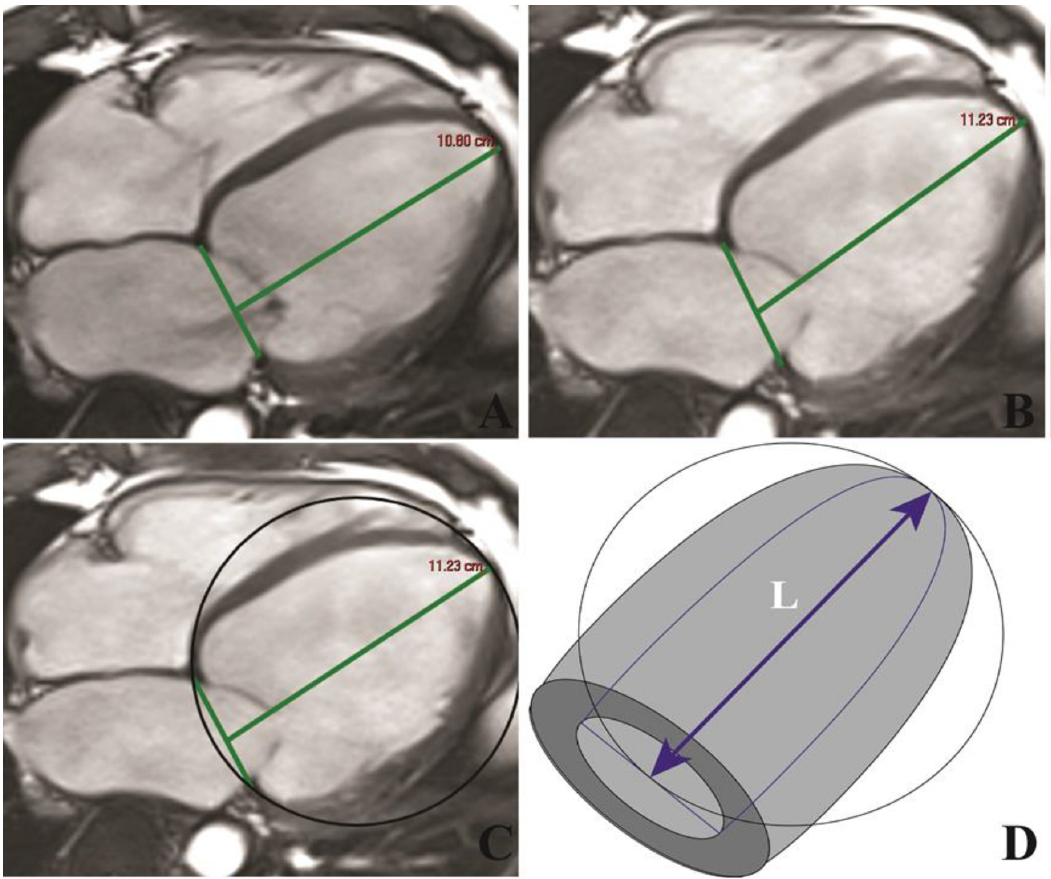
Figure 2. Representative image illustrating the technique for assessment of LAS ( A , B ) and LVSI ( C , D ) in a patient with severe NIDCM in end-diastole and end-systole, respectively. Abbreviations: LAS, left ventricular long axis strain; LVSI, left ventricular sphericity index; NIDCM, non-ischemic dilated cardiomyopathy.